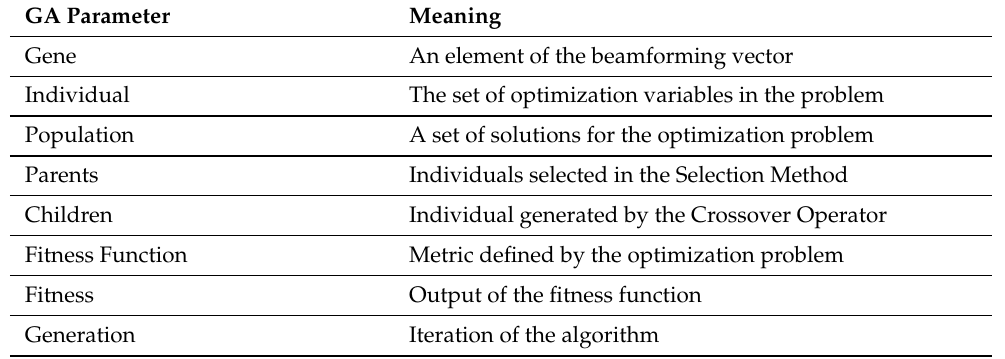
Table 1. The meaning of the main GA